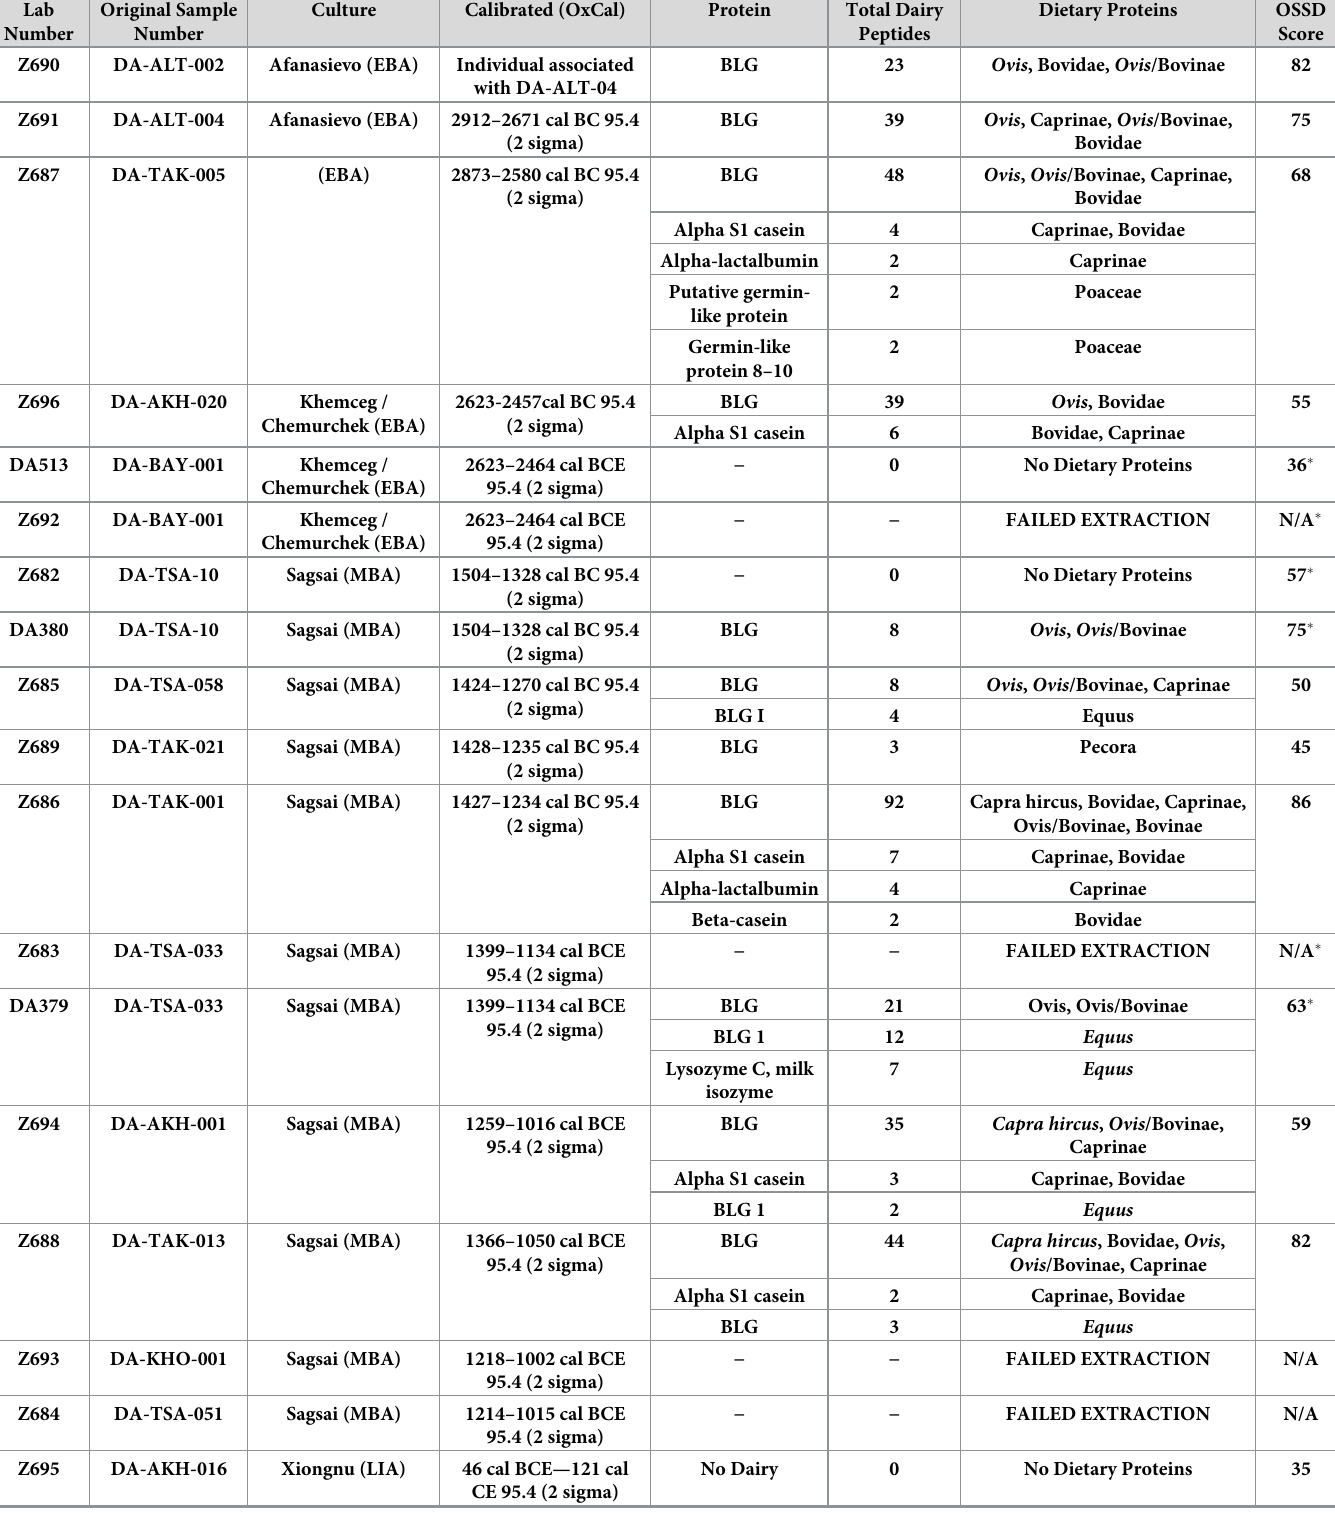
Table 1. Total dairy per individual. Lab